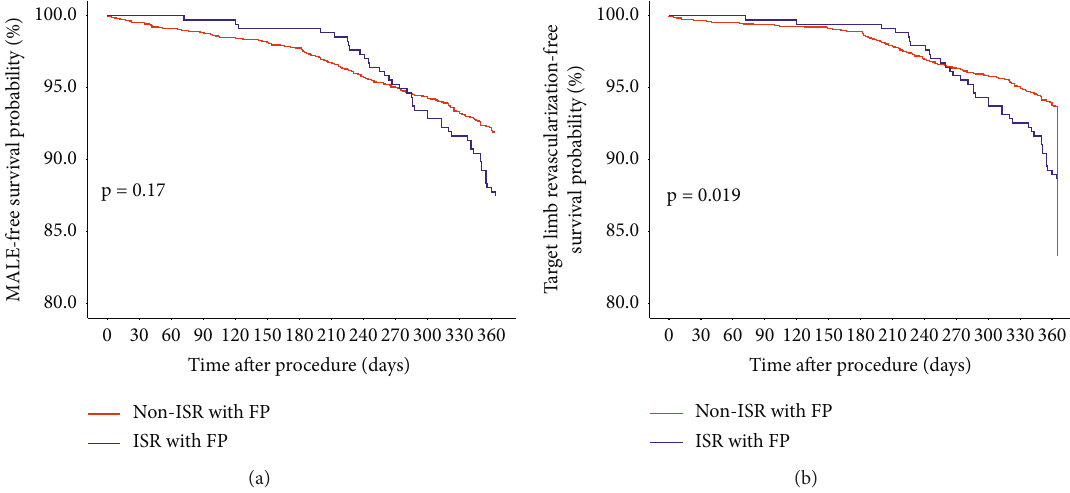
Figure 2: Survival curves comparing patients with femoropopliteal (FP) opliteal in-stent restenosis (ISR) and without ISR receiving endovascular treatment for symptomatic peripheral arterial disease (PAD). Kaplan–Meier curves showing that patients with FP ISR did not have significantly lower freedom from MALE at 12 months (a). Survival from target limb revascularization was significantly lower in the FP ISR group